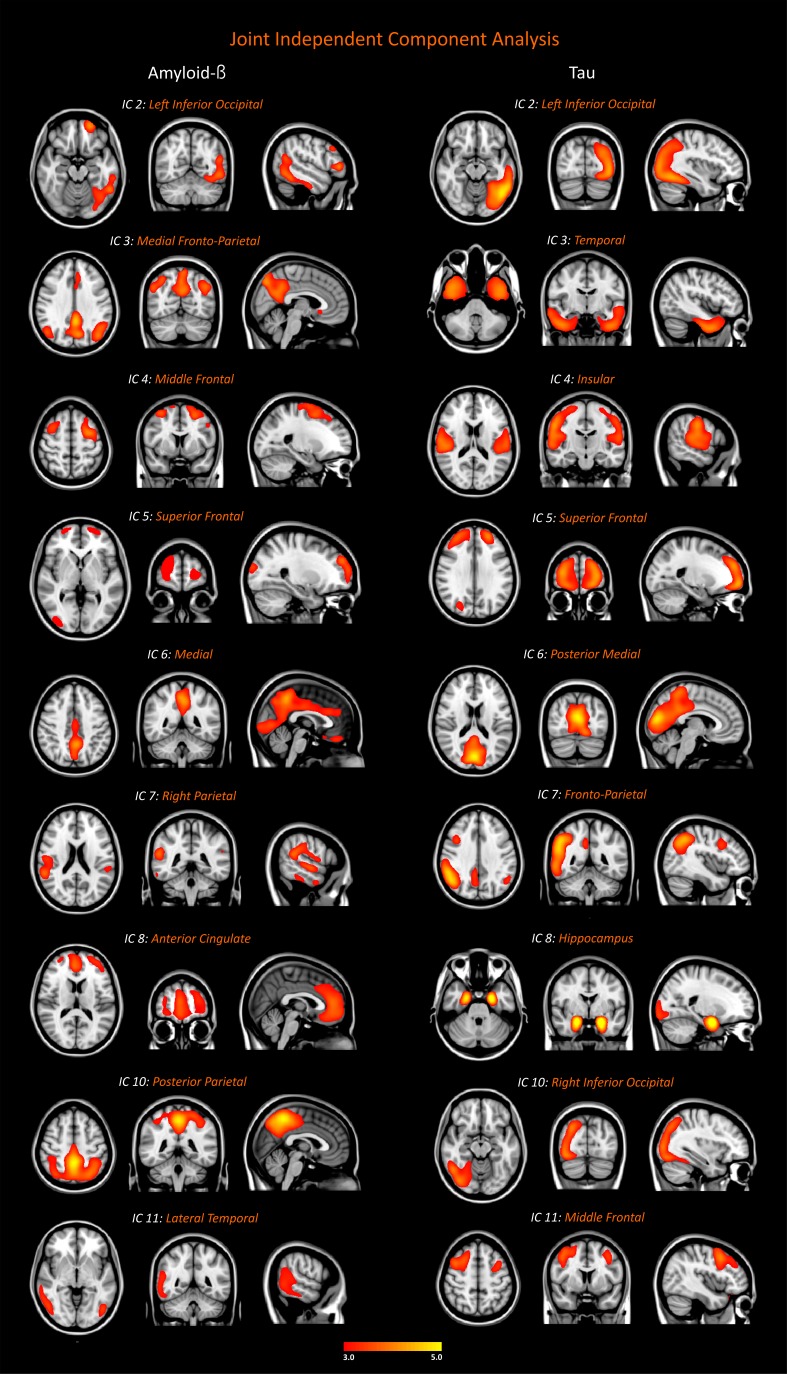
Networks of amyloid-β and tau accumulation in the whole cohort.We identified nine joint independent components (ICs) for amyloid-β and tau in the analyses of 18F-Flutemetamol and 18F-Flortaucipir PET data in the entire sample of 117 subjects (26 amyloid-β negative cognitively normal subjects, 34 amyloid-β positive cognitively normal subjects, 21 patients with mild cognitive impairment, 36 patients with Alzheimer’s disease). These components were thresholded with a z-score >2.0, which corresponds to a two-tailed significance value of p<0.05. Inclusion and exclusion criteria for the subjects included in this analysis can be found in Materials and methods.